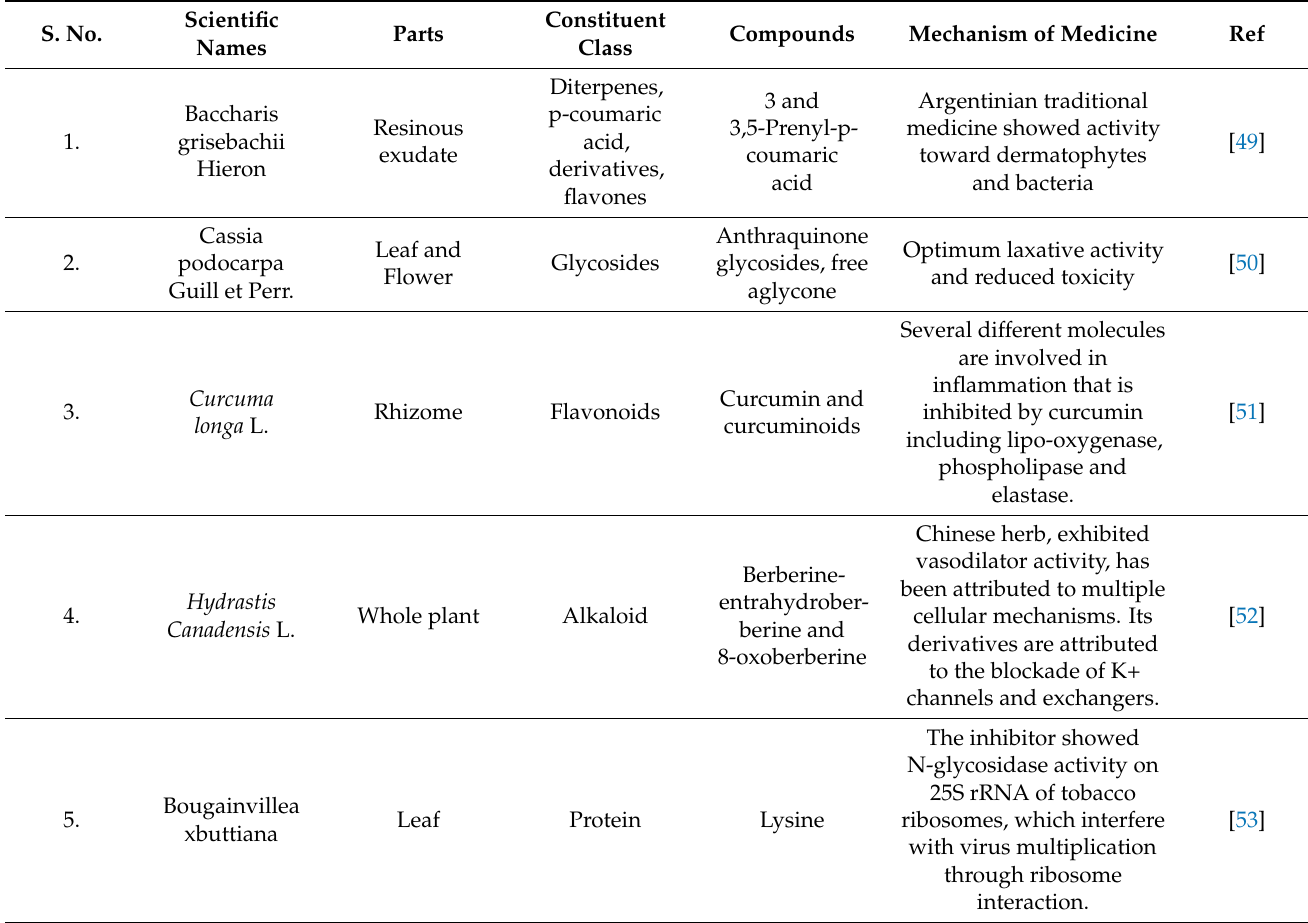
Table 2. Accounts of various traditional medicinal plants and their inhibitory